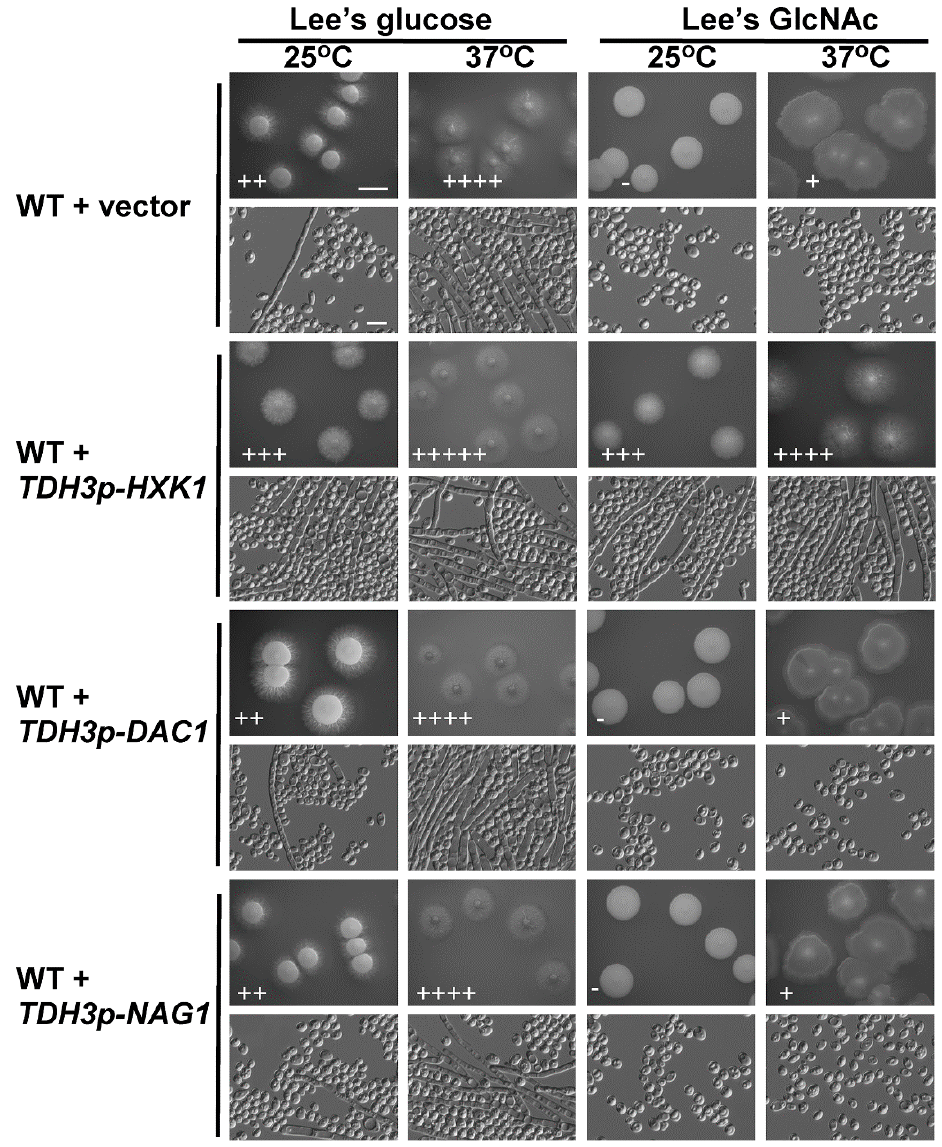
Figure 3. HXK1 overexpression enhanced C. tropicalis filamentous growth. WT or overexpression strains were plated on Lee’s agar plates containing glucose or GlcNAc, and cellular/colony morphology was imaged after 6 days of growth at 25 °C or 37 °C. The WT + vector strain (GH1374 + pCT3) served as a control. Five individual transformants for each gene were used for filamentous growth assays. The degree of hyphal growth is represented by “+” signs, with the percentages of filamentous cells being indicated as follows: +, 0.1%–5%; ++, 5%–20%; +++, 20%–40%; ++++, 40%–60%; +++++, > 60%. If no hyphal growth was evident, “ - “ was instead used to indicate cells (< 0.1%). Scale bars for colonies and cells were 2 mm and 10 μ m, respectively.